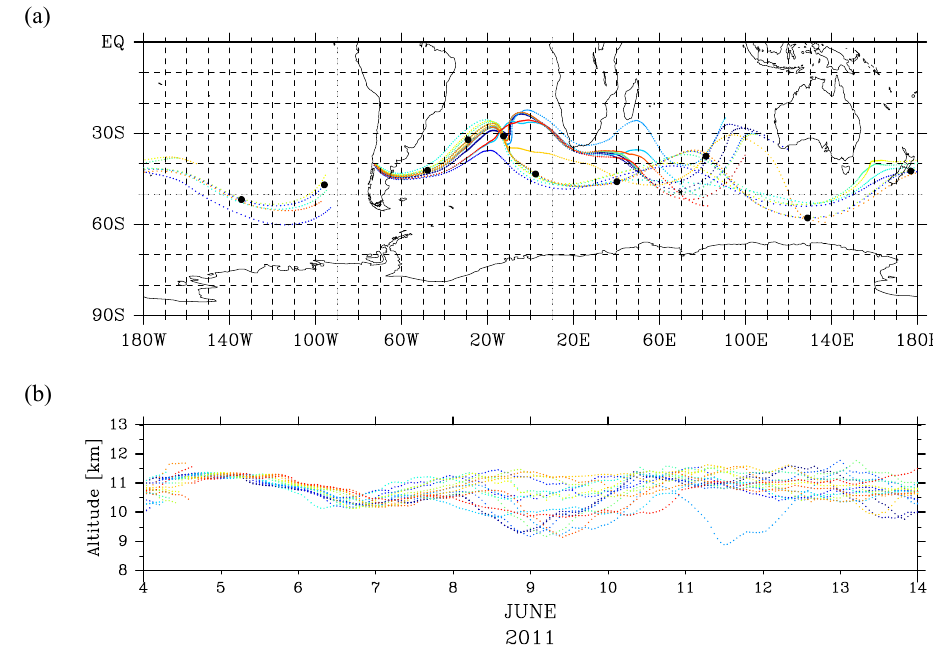
Fig.2 Figure 2. Ten-day isentropic forward trajectories of air parcels (colored lines) determined by using METEX. The starting position was the PCCVC (40.59 ◦ S, 72.11 ◦ W), at 11km above the surface. Large black dots mark each 24h period in the simulation. stratospheric background value of 1 . 42 × 10 − 4 sr − 1